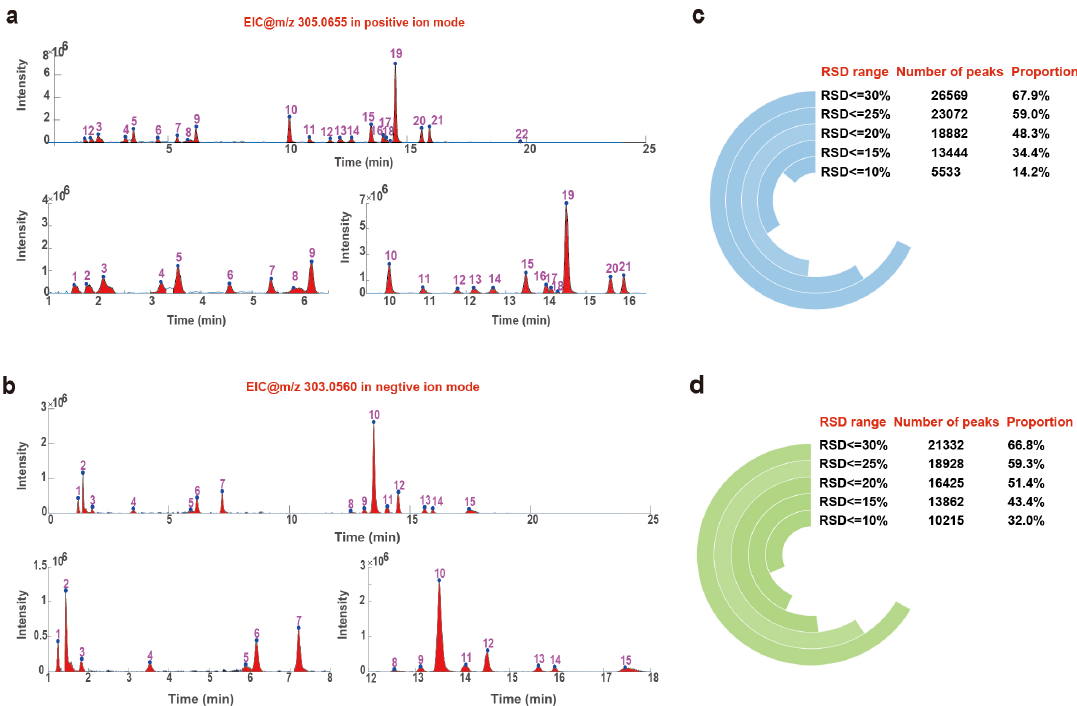
Figure 2. ( a ) EIC extraction and detail diagram example in the positive ion mode. ( b ) EIC extraction and detail diagram example in the negative ion mode. The data quality assessment diagram in the ESI+ mode ( c ) and the ESI − mode ( d